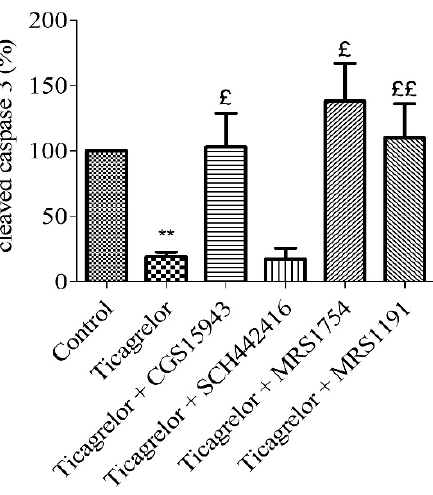
(Table 1): 10 µ M LY294002 (PI3K), 100 µ M 5-HD (mitoKATP channel), and 10 µ M L-NAME (NOS) and 5 µ M indomethacin (COX). The anti-apoptotic e ff ect (relative to control) of 10 µ M